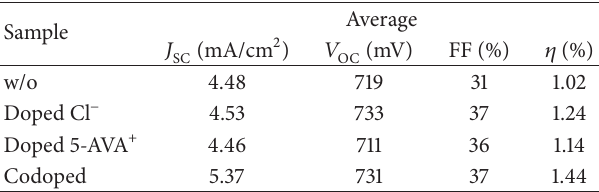
Table 1: Experiment average photovoltaic parameters of single- mesoporous PSCs devices based on different